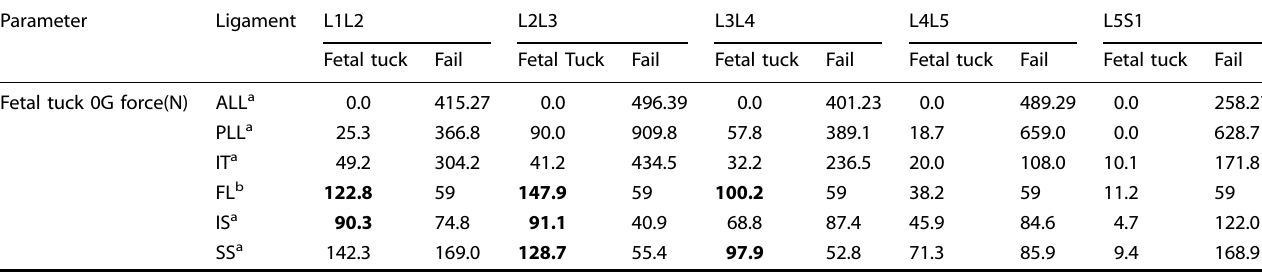
Table 1. Ligament forces predicted at fetal tuck 0G (fetal tuck), compared to failure forces from literature (Fail). Parameter